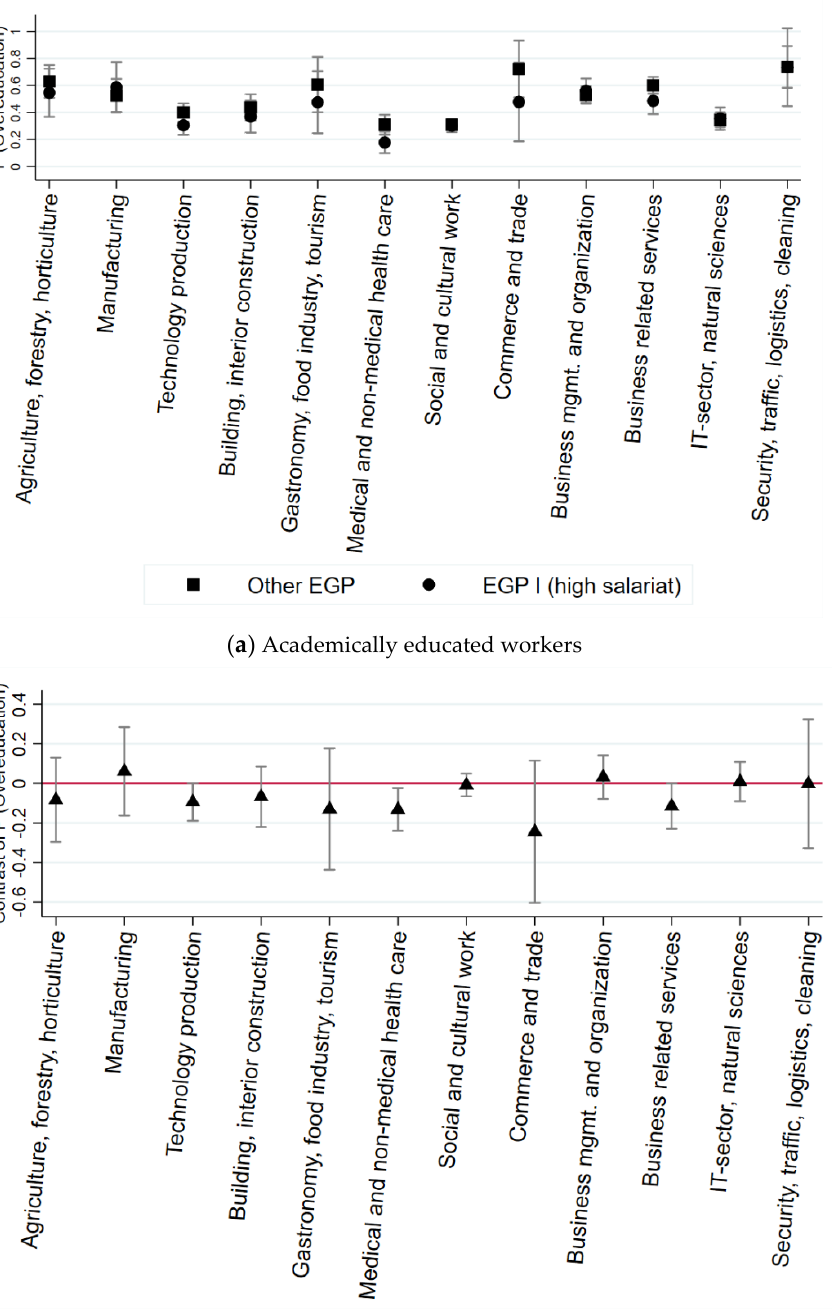
Figure A3. ( a ) Predicted probability of overeducation (objective indicator) (AME) within academic education for each combination of educational field and social background; ( b ) Social background differences (EGP I high salariat-other EGP) of predicted probability of overeducation. Confidence intervals at 95-percent level. Weighted results. Data: BIBB/BAuA Employment Survey 2018, authors’ own calculations.